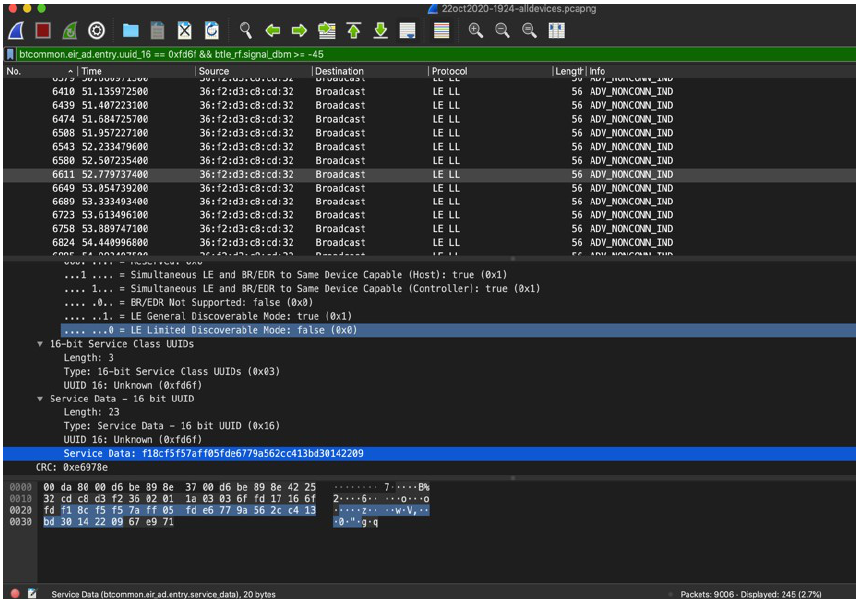
Figure 4. The Received RPI of a random package.